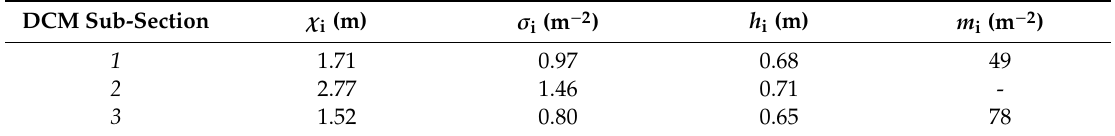
Table 2. Hydraulic and vegetative parameters referred to the flow rate Q 2 = 0.16 m 3 · s − 1 : χ i (m), σ i (m 2 ), h i (m) and m i (m − 2 ) are respectively the wetted perimeter, the flow cross sectional area, the water level at bankfull and the riparian vegetation density of each DCM sub-section. DCM Sub-Section